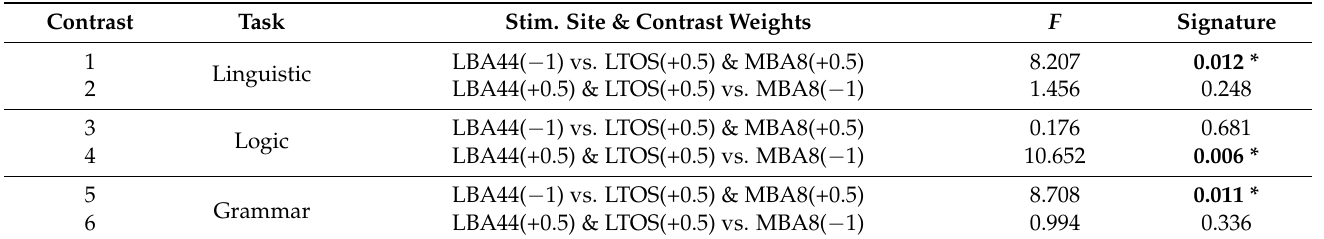
Table 3. Linear trend analysis.